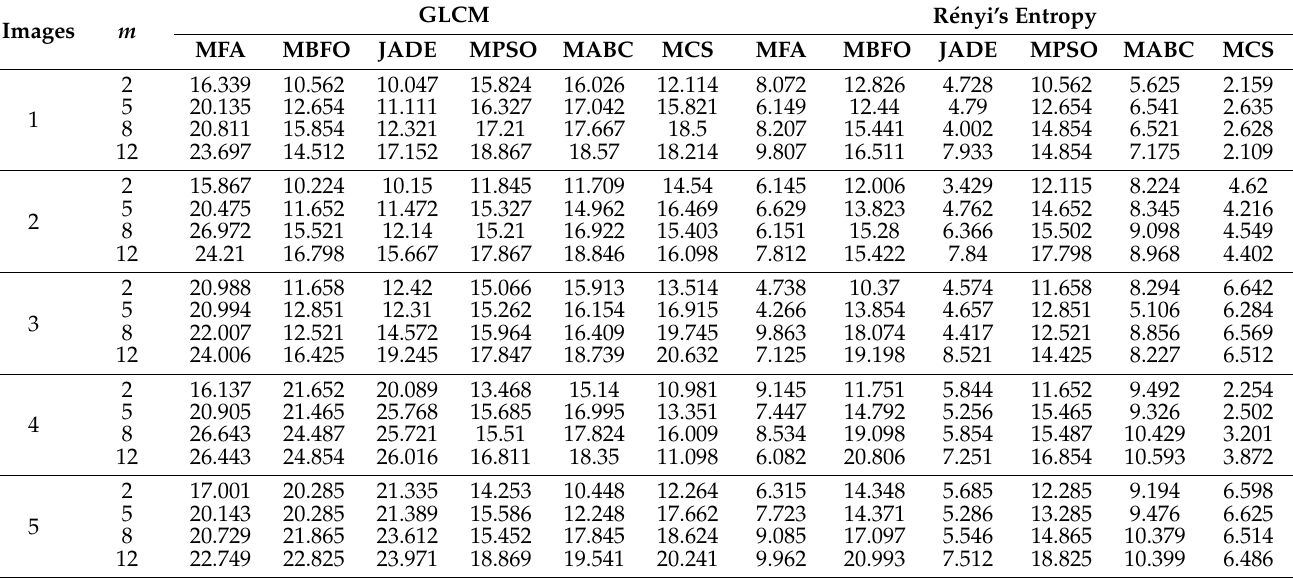
Table A6. CPU time using different optimization algorithms with GLCM and R é nyi’s entropy method. Images